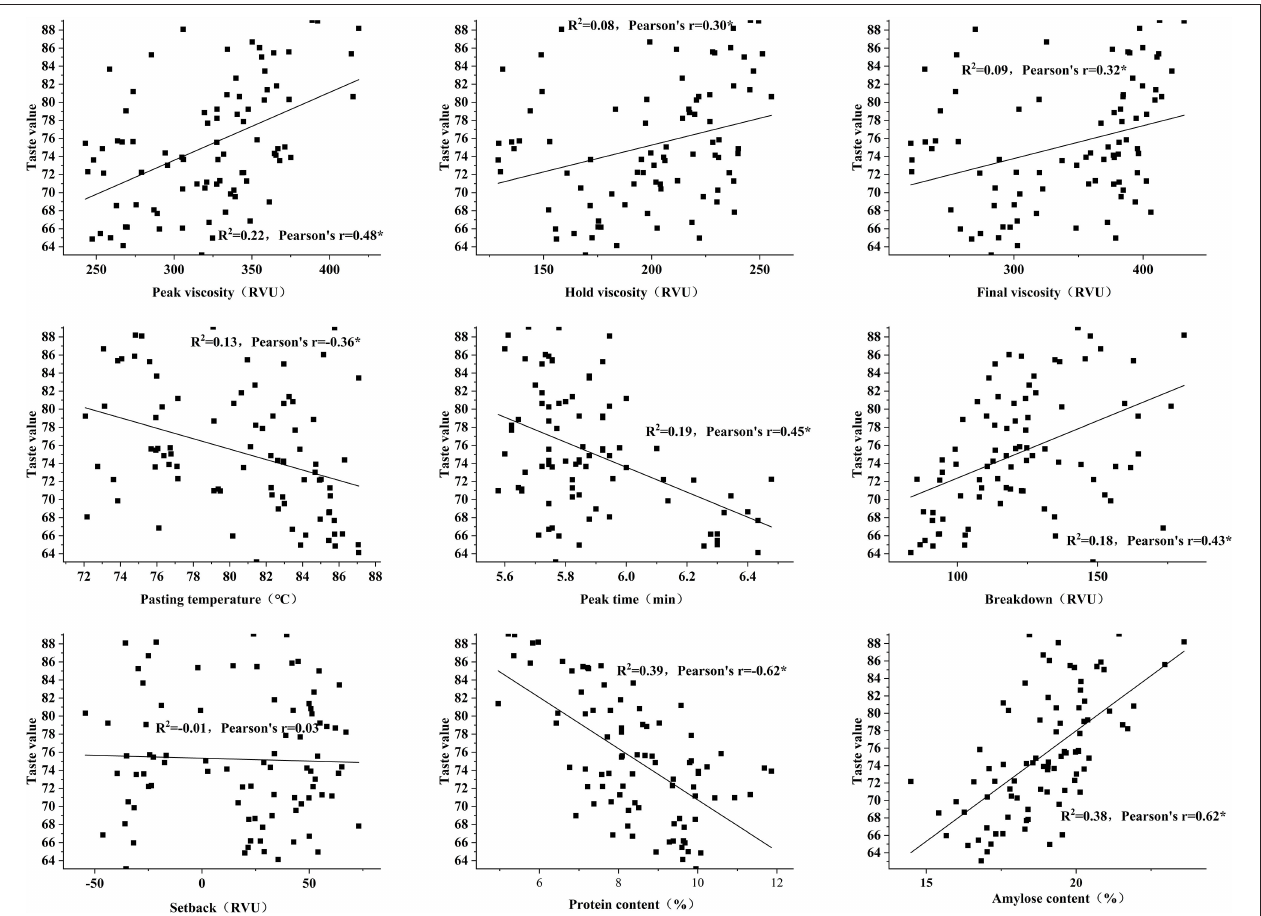
TABLE 1 | Correlations among protein content, amylose content, and rapid viscosity analyzer (RVA) profiles. Peak viscosity Hold viscosity Breakdown Final viscosity Setback Pasting temperature Peak time Protein content − 0.48* − 0.29* 0.17 0.28* 0.22* Amylose content 0.28*